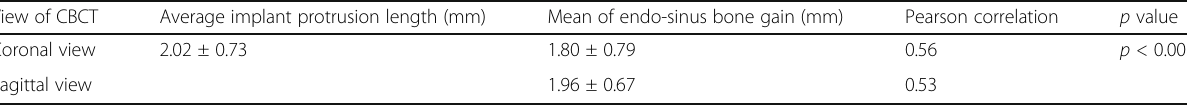
Table 2 Correlation between implant protrusion length and endo-sinus bone gain View of